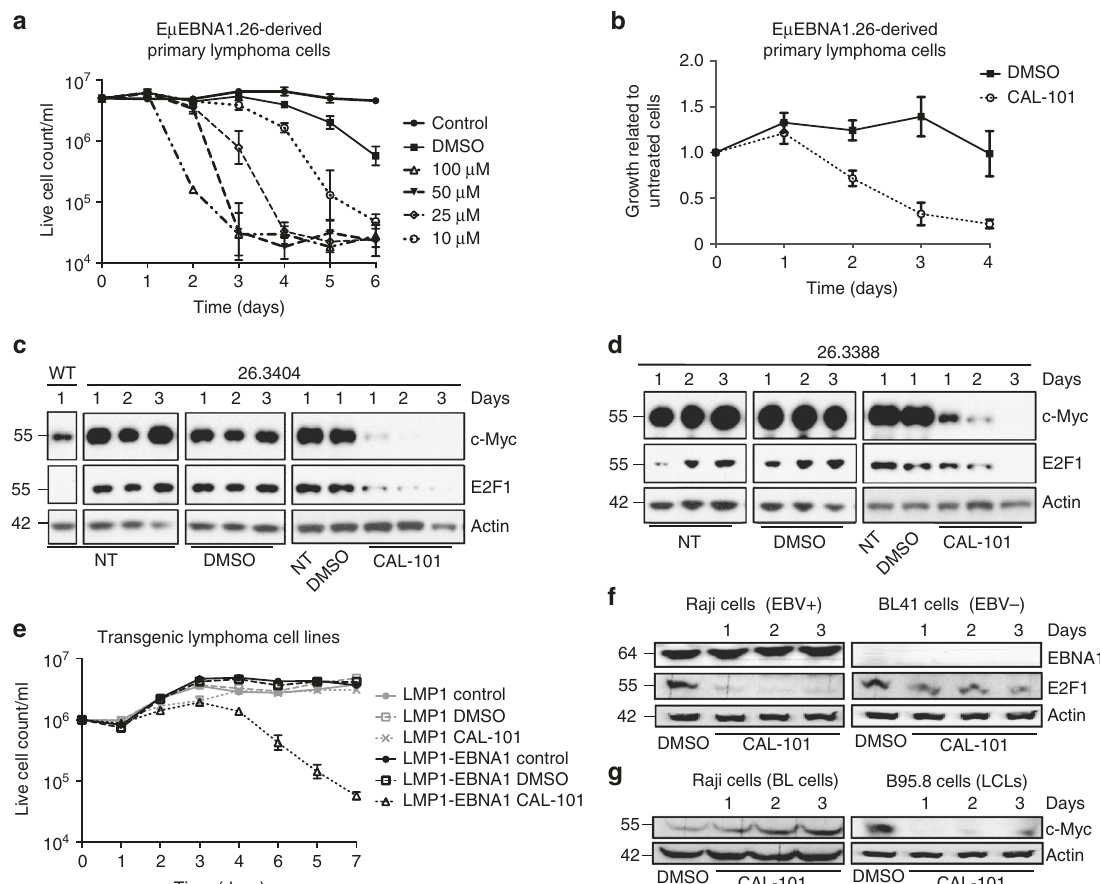
Fig. 6 E2F1, c-Myc expression and cell viability are mediated via PI3K δ in EBNA1 transgenic mouse tumour cells. a Primary lymphoma cells derived from mice were cultured (in triplicate) with 10 – 100 µ M CAL-101 or DMSO, or no additive (control) for 6 days. Rapid cell death correlates with increasing concentrations of CAL-101. b Cells from three different explanted primary EBNA1-positive transgenic lymphomas were each cultured in triplicate for 4 days with 10 µ M CAL-101 added (in 0.01% DMSO) or 0.01% DMSO. The ratio of CAL-101 and DMSO-treated cell counts against untreated cell counts is graphed. c , d Western blots showing a time course of the expression of E2F1 and c-Myc in non-transgenic cells (WT) and using transgenic cells from two different primary tumours (ID:26.3404 [C] and 26.3388 [D]) (see also Supplementary Fig. 9a). Explanted E µ EBNA1 transgenic tumour cells were cultured for up to 4 days, with no treatment (NT), or with vehicle (DMSO) or with daily treatment of 10 µ M CAL-101, as indicated. E2F1 and c-Myc expression in the EBNA1 transgenic lymphoma cells are markedly reduced by CAL-101 treatment. e Cell growth was measured for 7 days in two mouse B cell lymphoma cell lines LMP1 positive (ID: 39.415) and the bi-transgenic LMP1 and EBNA1 positive (ID: 3959.48). Cells were cultured with daily addition of CAL-101 to 50 µ M, or with vehicle (DMSO) and viable cells counted. f Western blots showing the expression of E2F1 in two Burkitt ’ s lymphoma cell lines carrying c-myc gene translocation. Raji is EBV positive and BL41 is EBV negative. Both were treated with CAL-101 (10 µ M) for indicated time. g Western blots showing c-Myc expression following treatment with CAL-101 (10 µ M) in Raji and the lymphoblastoid cell line B95.8 (no c-myc gene translocation). Western blots represent n ≥ 3; Actin was used as a loading control. The values in a , b and e represent the mean data from three independent experiments with s.d part of the viral strategy to evade the MHC class I-restricted antigen presentation pathway. Hence, targeting mRNA transla- tion allows the virus to hit two birds with one stone: evade the immune system and at the same time support the proliferation of infected cells. Despite being the only EBV antigen expressed in all BL and also consistently expressed in all other EBV-associated Fig. 7 mRNA translation stress on EBNA1 polysomes activates PI3K δ and E2F1 synthesis. Translation attenuation in cis caused by the GAr sequence of the EBNA1 mRNA causes translation stress, which results in activation of PI3K δ and the induction of E2F1 mRNA translation independent of AKT and mTOR pathways. The newly synthesised E2F1 induces downstream target genes, including cyclins and c-myc , resulting in an increase in cell growth show that E2F1 and c-Myc expression in primary lymphomas and inhibited following CAL-101 treatment. It is, thus, likely that the reported inverse correlation between the expression levels of